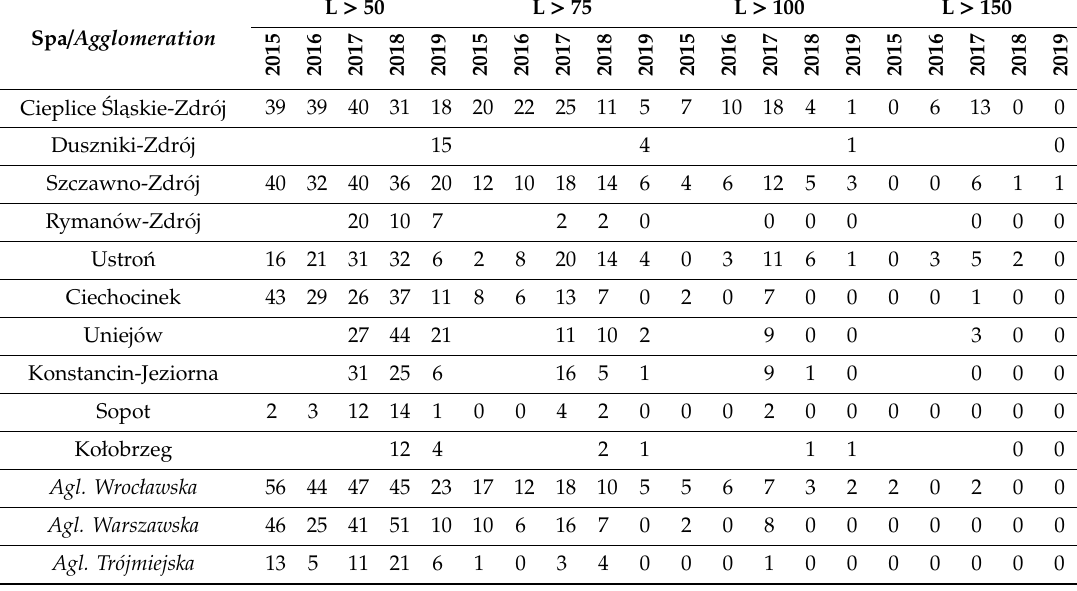
Table 4. The number of days with exceedances of the limit value (L > 50), episode threshold (L > 75), information (L > 100), and alert threshold (L > 150) in the examined spas and agglomerations in